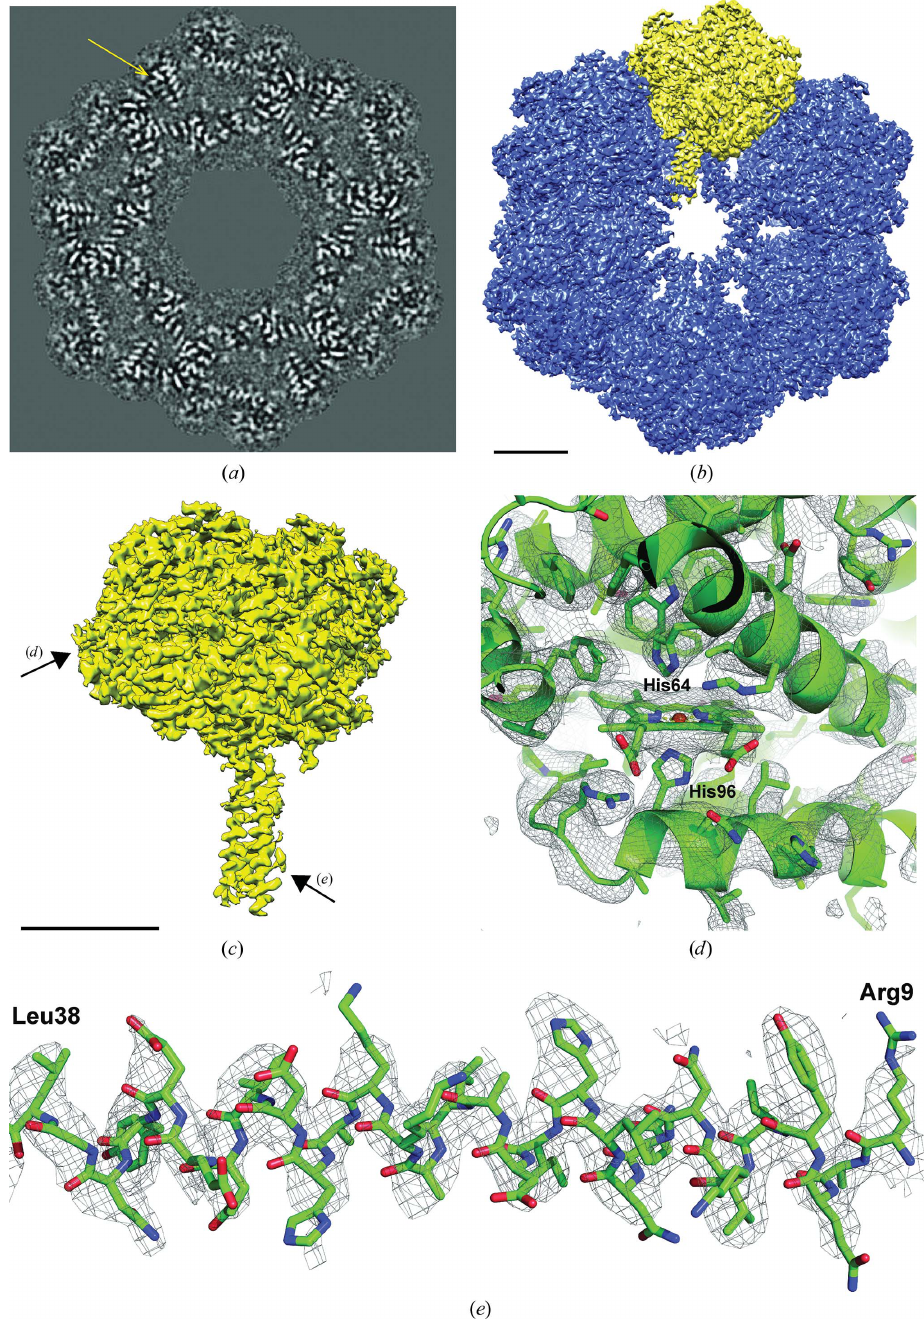
Figure 12 Final cryo-EM map of worm haemoglobin (scale bars indicate 50 A˚ ). ( a ) Slice through the cryo-EM three- dimensional reconstruction perpendicular to the main sixfold symmetry axis, with the yellow arrow pointing at a haem group sandwiched between two (cid:4) -helices; the proximal histidine contacting the iron in the haem group is visible. ( b ) Surface rendering of the top view (along the sixfold axis); the asymmetric unit (1/12th of the D 6 reconstruction; see Supplementary Movie S1) is marked in yellow. ( c ) The asymmetric unit (‘protomer’ or ‘1/12th unit’) with arrows pointing at the globin fold shown in ( d ) and the (cid:4) -helix shown in ( e ). ( d ) View of one the better resolved haem groups: both the proximal and the distal histidine ( b globin chain: His96 and His64) are well embedded in density. ( e ) View of one (cid:4) -helix (L 1 linker chain; Arg9– Leu38) in the triple coiled-coil region: the side chains fit nicely into the three-dimensional reconstruction. The atomic model was deposited as PDB entry